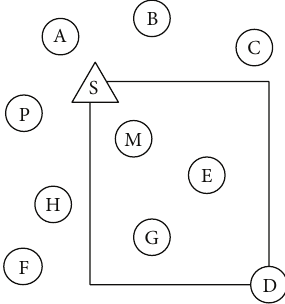
Figure 2: Node location